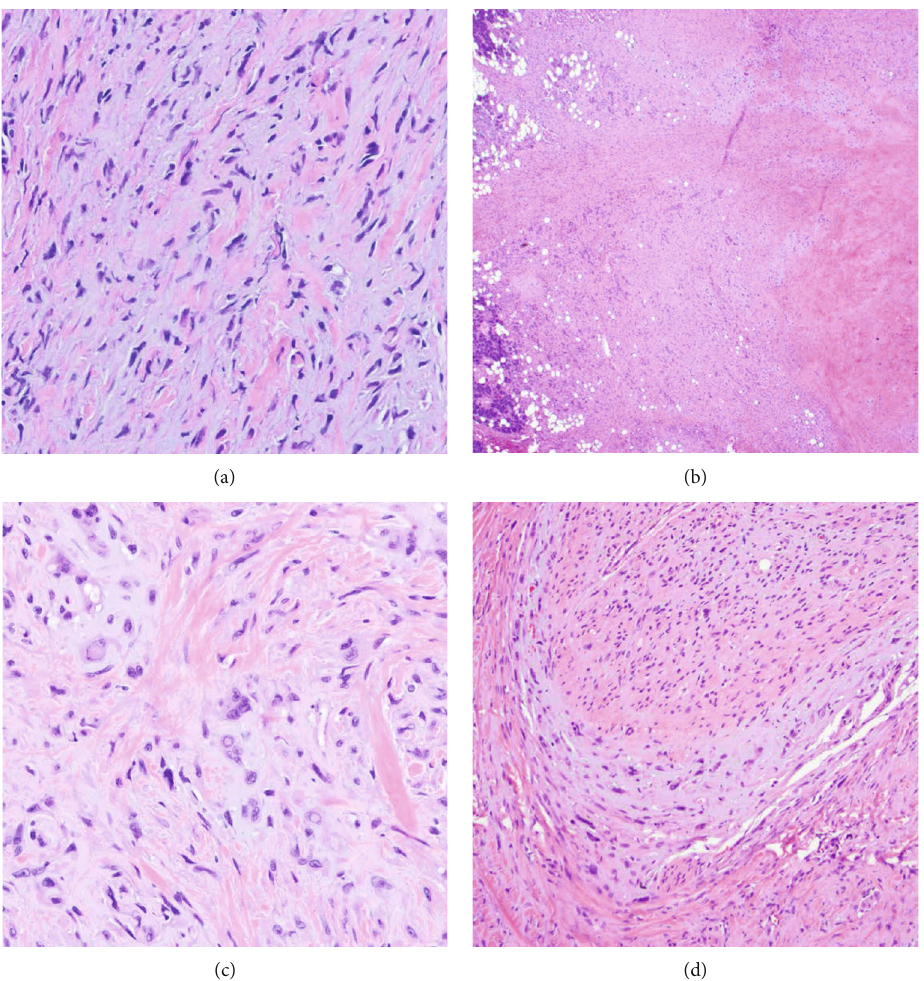
Figure 2: (a) Biopsy of the parotid gland revealed a neoplasm comprised of atypical cells in a fi bromyxoid stroma (H&E ∗ , 400x). Resection of the parotid mass. (b) Tumor in fi ltrating adjacent tissue (H&E ∗ , 20x). (c) Tumor is comprised of atypical cells in small clusters with occasional intracytoplasmic vacuoles and foci of cytologic pleomorphism (H&E ∗ , 400x). (d) Perineural invasion (H&E ∗ , 100x). ∗ Hematoxylin and eosin.